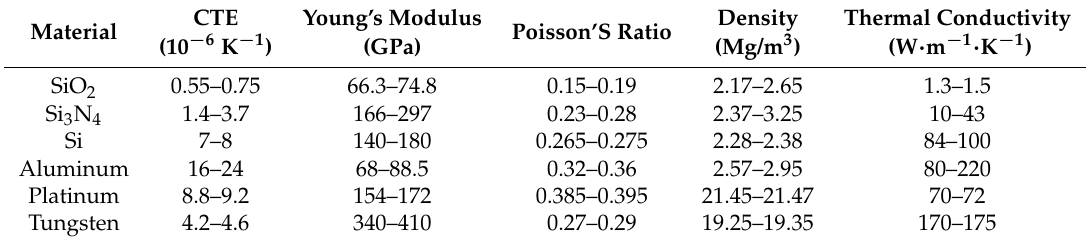
Table 2. Material properties ranges for layers typically found in the SMO sensor